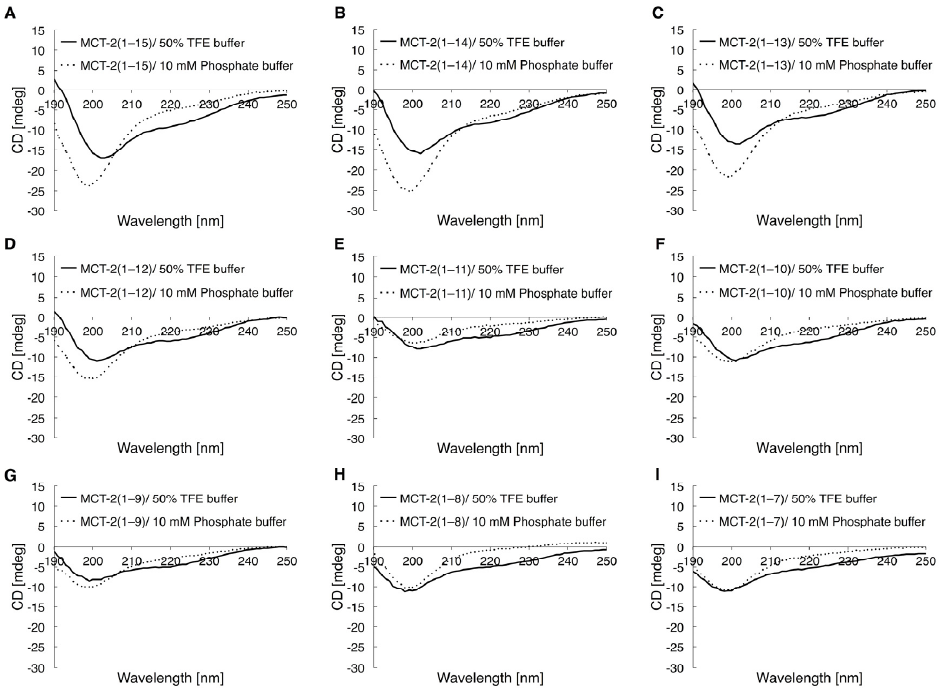
Figure 5. CD spectra of MCT-2(1–15) and its derivatives. The CD spectra of MCT-2(1–15) ( A ), MCT-2(1–14) ( B ), MCT-2(1–13) ( C ), MCT-2(1–12) ( D ), MCT-2(1–11) ( E ), MCT-2(1–10) ( F ), MCT-2(1–9) ( G ), MCT-2(1–8) ( H ), and MCT-2(1–7) ( I ) in 50% TFE buffer (solid lines) or 10 mM phosphate buffer (pH 7.4) (dashed lines) were measured with a CD spectrometer. CD data with peptide solutions (final concentration: 100 µ M) were the average of five scans collected at 1 nm intervals. The results are expressed as optical rotation (mdeg).